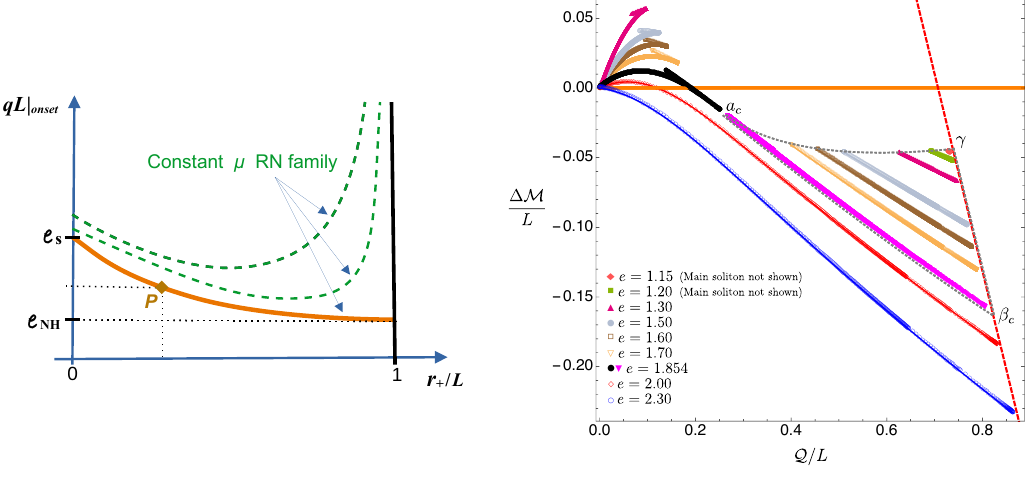
= qL | as a function of the Figure 1 . Left panel: sketch of the scalar field electric charge e onset onset horizon radius R = r of RN BHs in a box (sketched from figure 2 of [21]). The orange curve + + /L in the bottom — that starts at ( R ) = (0 , e ) and terminates at ( R ) = (1 , e ) — describes + , e + , e S NH the minimal onset charge (which occurs at extremality, µ = µ ). That is, (non-)extremal RN BHs ext can be unstable if an only if e is higher than the one identified by this orange onset curve. On the other hand, if we pick an RN family with constant µ < µ , for instability, we need e to be higher ext than the associated green dashed line e ( R ) | also shown. In particular, we see that if we + const µ chose a charge in the range e , RN BHs are unstable if and only if they are between the ≤ e ≤ e NH S orange minimal onset curve and the horizontal line to the right of point P (gold diamond). Right panel: a survey of boson stars for different values of e , for e ≥ e γ [28]. For a given e ∈ [ e γ , e c [ we have the main (perturbatively connected to (0 , 0) ) and secondary (non-pertubative) solitons (which only exist in the region bounded by the auxiliary grey dashed closed curve a ). The secondary c β c γ soliton curve with e just above e is close to the point γ , while the soliton with e = 1 . 854 , just below γ e c , is the magenta curve (very close to a c β c ). Note that the gap in Q /L between the main soliton and the secondary one starts very large at e = e but then decreases and goes to zero precisely γ at e = e c